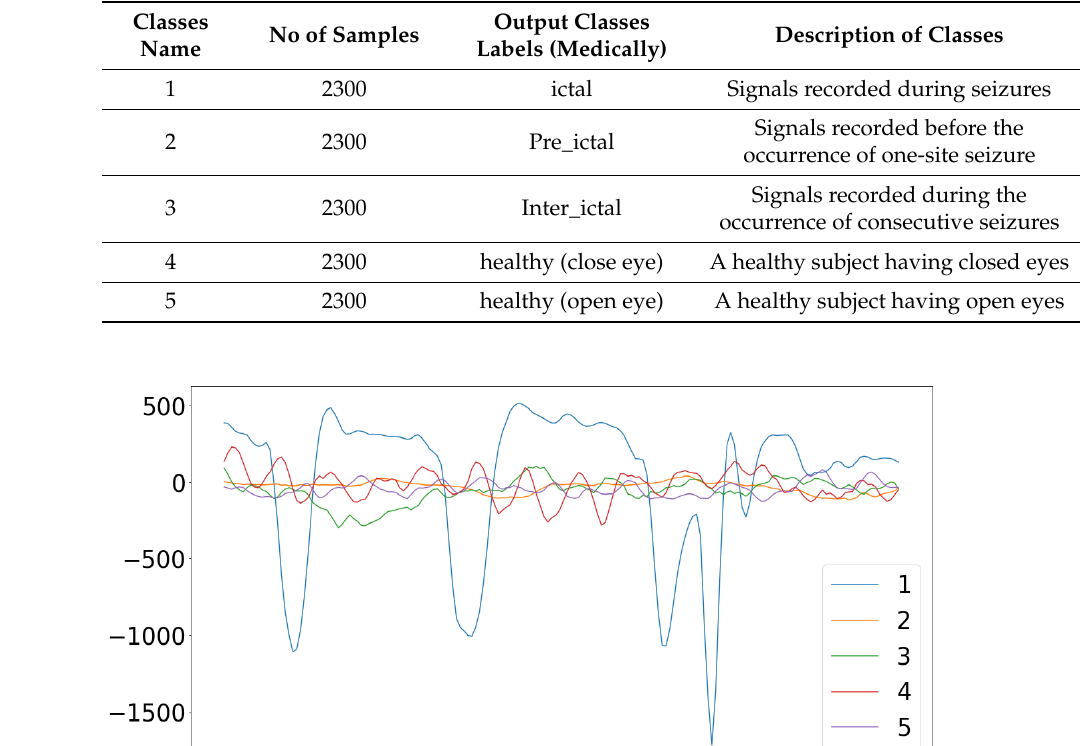
Table 1. Details of the Epileptic Dataset Classes.